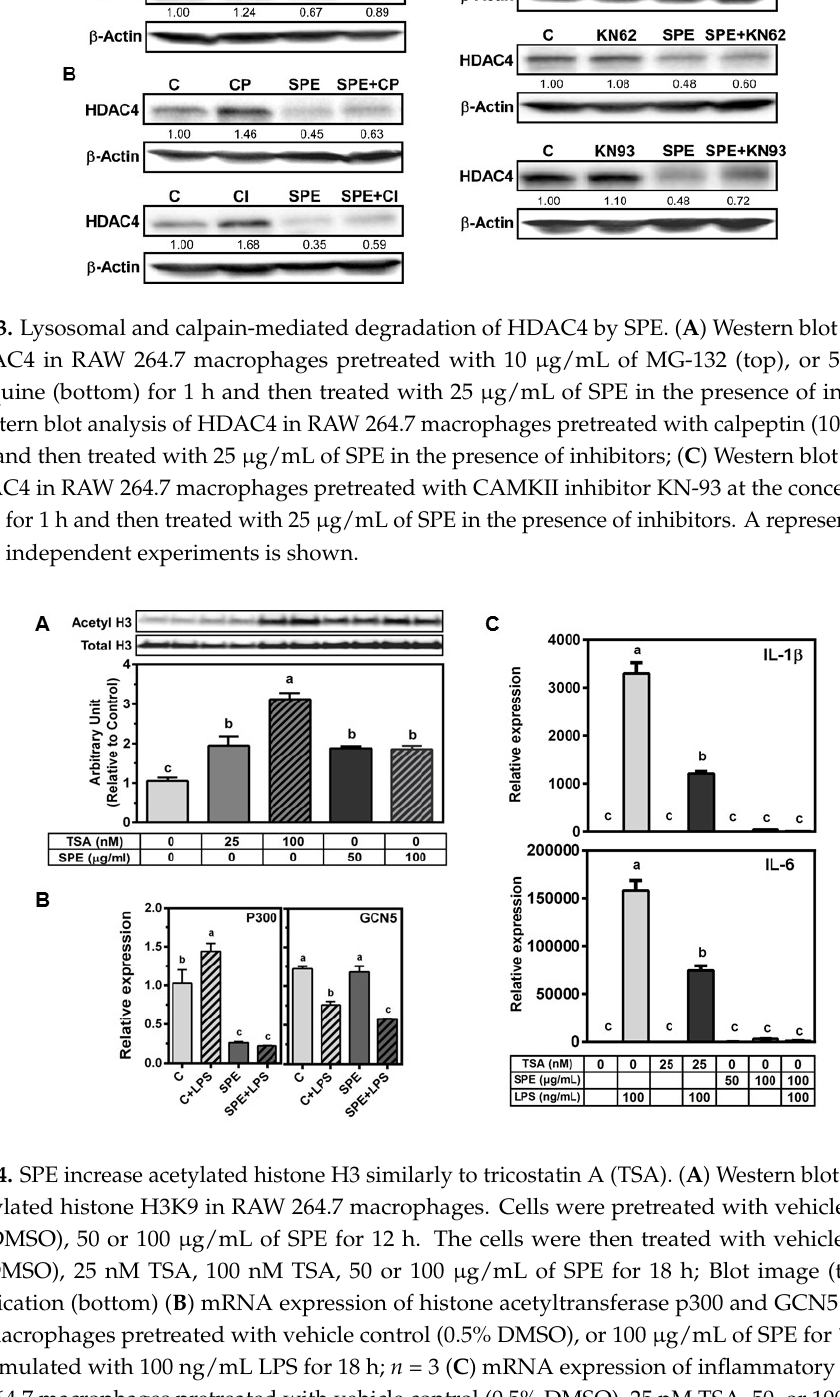
Nutrients 2016 , 8 , 381 5 of 12 Figure 2. SPE reduced HDAC proteins in a dose and time ‐ dependent manner in bone marrow ‐ derived macrophages (BMDM). ( A ) Western blot analysis of HDAC2, 3, and 4 in BMDM treated with 100 μ g/mL of SPE for indicated amount of time; ( B ) Western blot analysis of HDAC2, 3, and 4 in BMDM treated with indicated concentration of SPE for 3 h. A representative blot of 2–3 experiments is shown. 3.2. The Lysosome, Calpain Proteases, and Ca 2+ /Calmodulin ‐ Dependent Protein Kinase II Are Involved in the Rapid HDAC4 Degradation by SPE HDAC4 protein was rapidly reduced by SPE, much faster than HDAC2 and 3. Therefore, we investigated potential mechanisms of action for HDAC4 protein degradation. Two major protein degradation pathways in mammalian cells involve proteasomes and lysosomes. We used MG ‐ 132 (MG) and chloroquine (CQ), inhibitors of the proteasome and lysosomal acidification, respectively, to evaluate the role of proteasomes and lysosomes in HDAC4 degradation facilitated by SPE in RAW macrophages. MG was not able to counteract the decrease in HDAC4 protein by SPE and in fact, HDAC4 protein was almost non ‐ detectable in the presence of MG (Figure 3A). When macrophages were incubated with CQ, the inhibitor modestly increased basal HDAC4 protein levels and attenuated SPE ‐ induced HDAC4 protein reduction although it did not completely abolish the SPE effect. HDAC4 has been reported to contain a PEST ‐ domain, which is recognized by calpain proteases